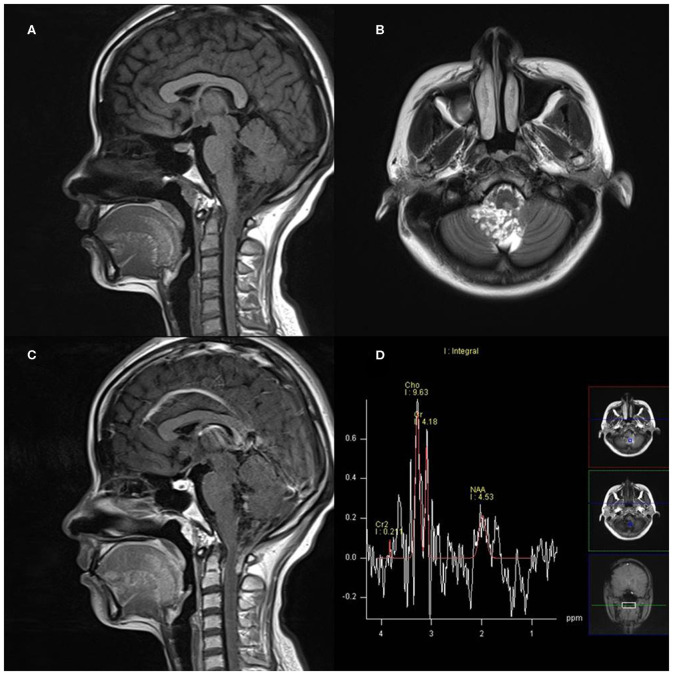
A 27-year-old woman with infratentorial anaplastic ependymoma in the fourth ventricle on (A) T1-weighted image, (B) T2-weighted image, (C) contrast T1-weighted image, and (D) magnetic resonance spectroscopy (MRS). The tumor appears as heterogeneous signal intensity with increased Cho/Cr and marked decreased NAA.